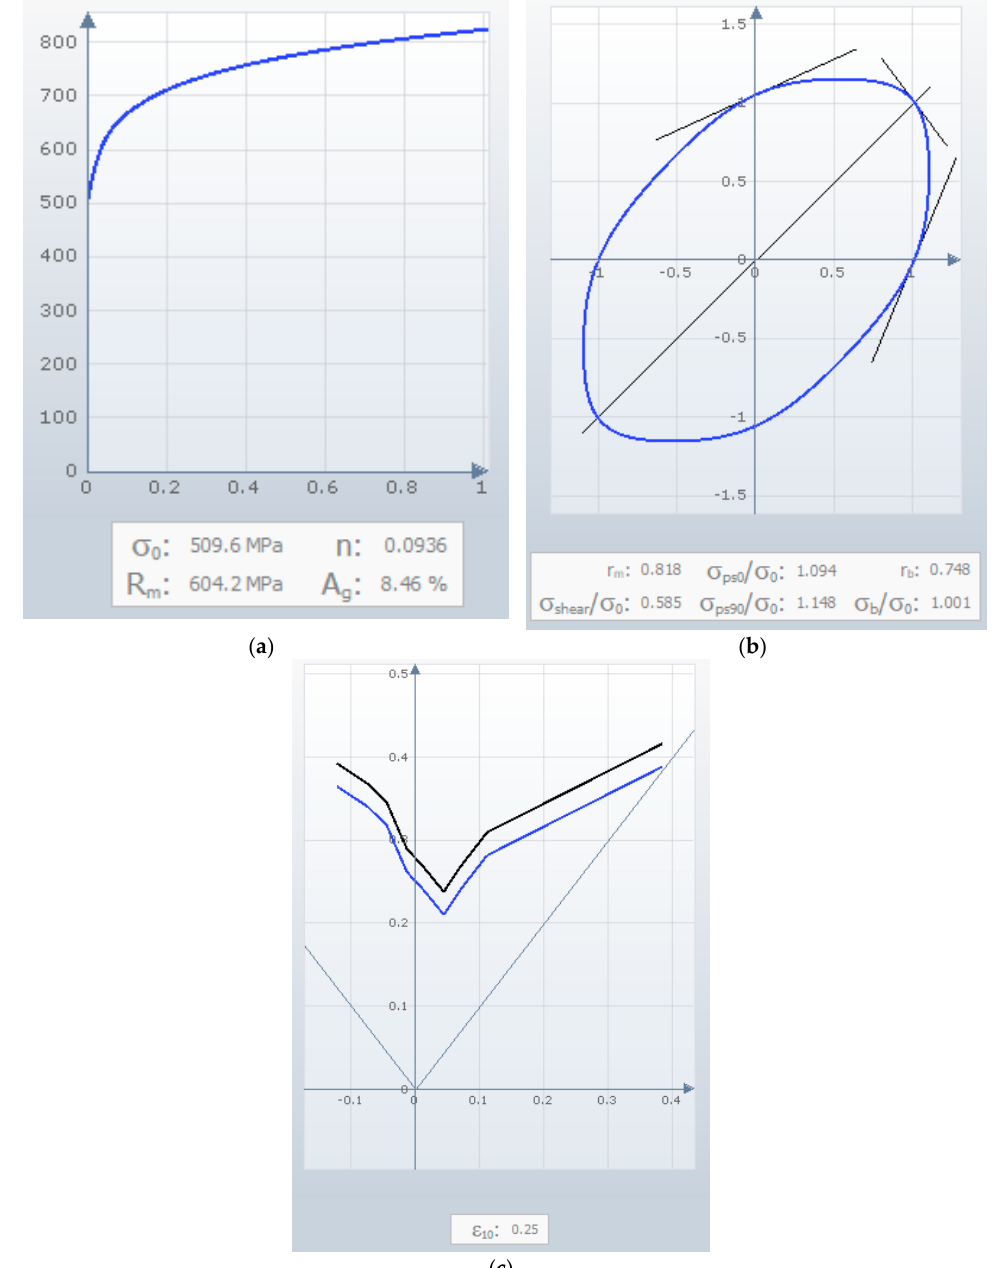
Figure 2. ( a ) Hardening curve; ( b ) yield surface with BBC criterion; and ( c ) Formability Limit Curve (FLC).